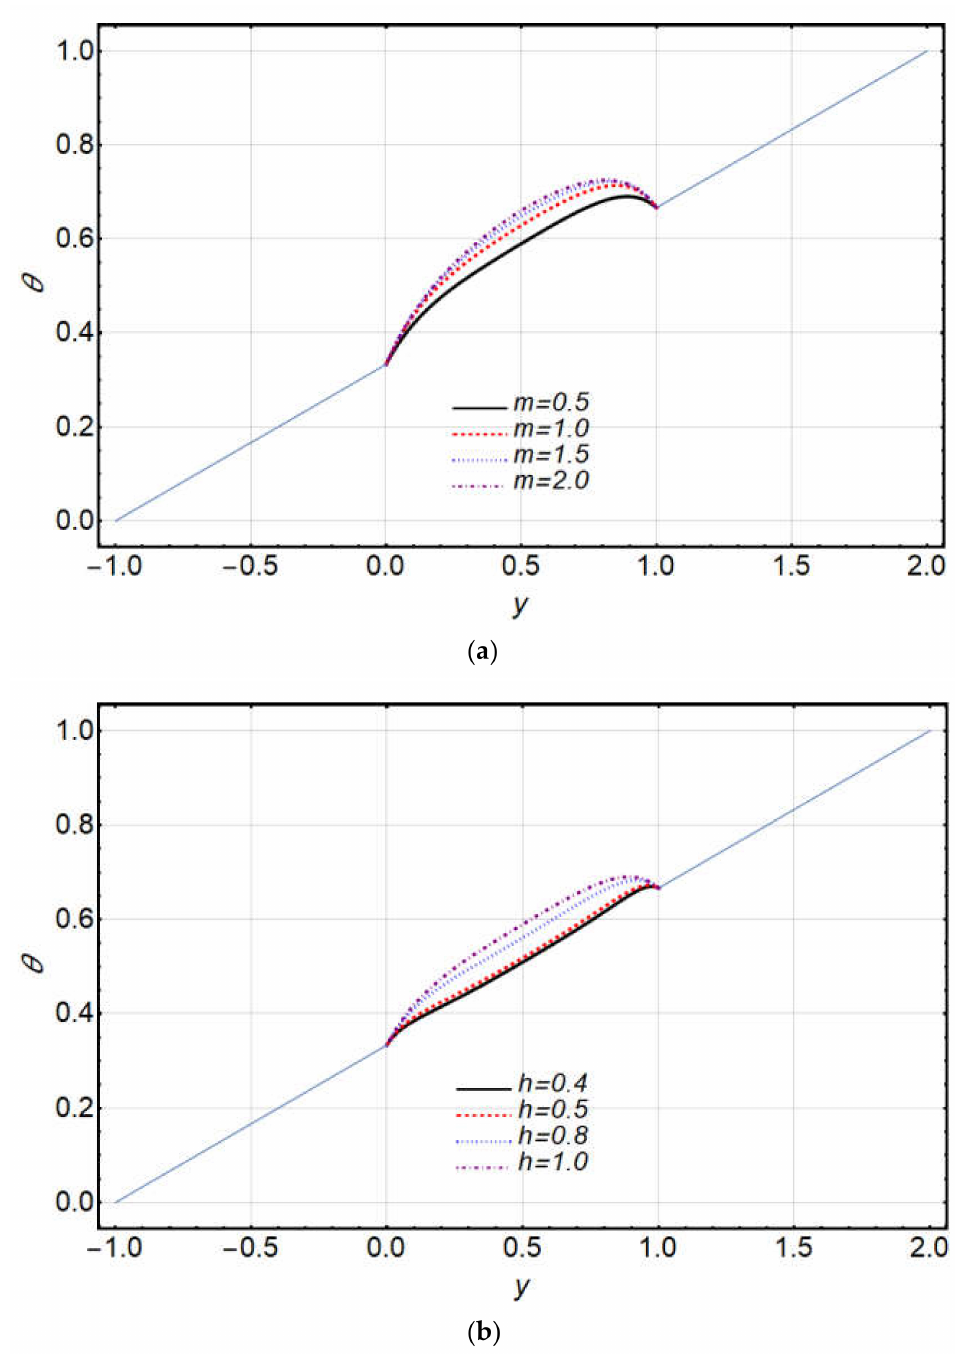
Figure 13. Temperature distribution against ( a ) m , ( b ) h